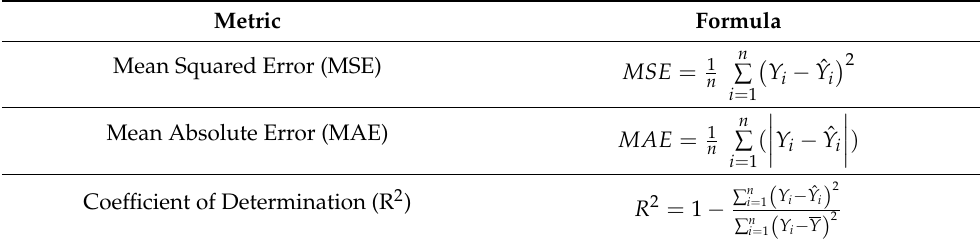
Table 2. Performance